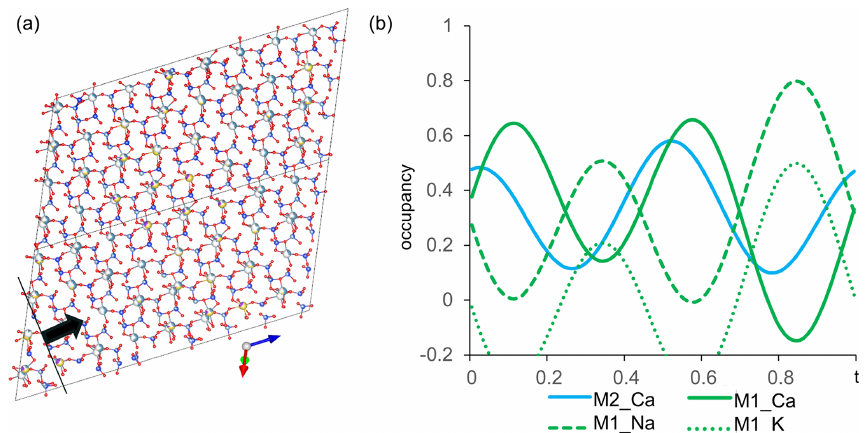
Figure 13. (a) Modulated structure of labradorite displayed over four cells along the a , b and c axes. Viewing direction along [1–10] providing the view perpendicular to the modulation vector [11–4] (black line) and the modulation direction (black arrow). Only one layer of the M positions is displayed. (b) Modulation of the occupancy of the M site versus t . M1 is displayed in green and M2 in cyan.